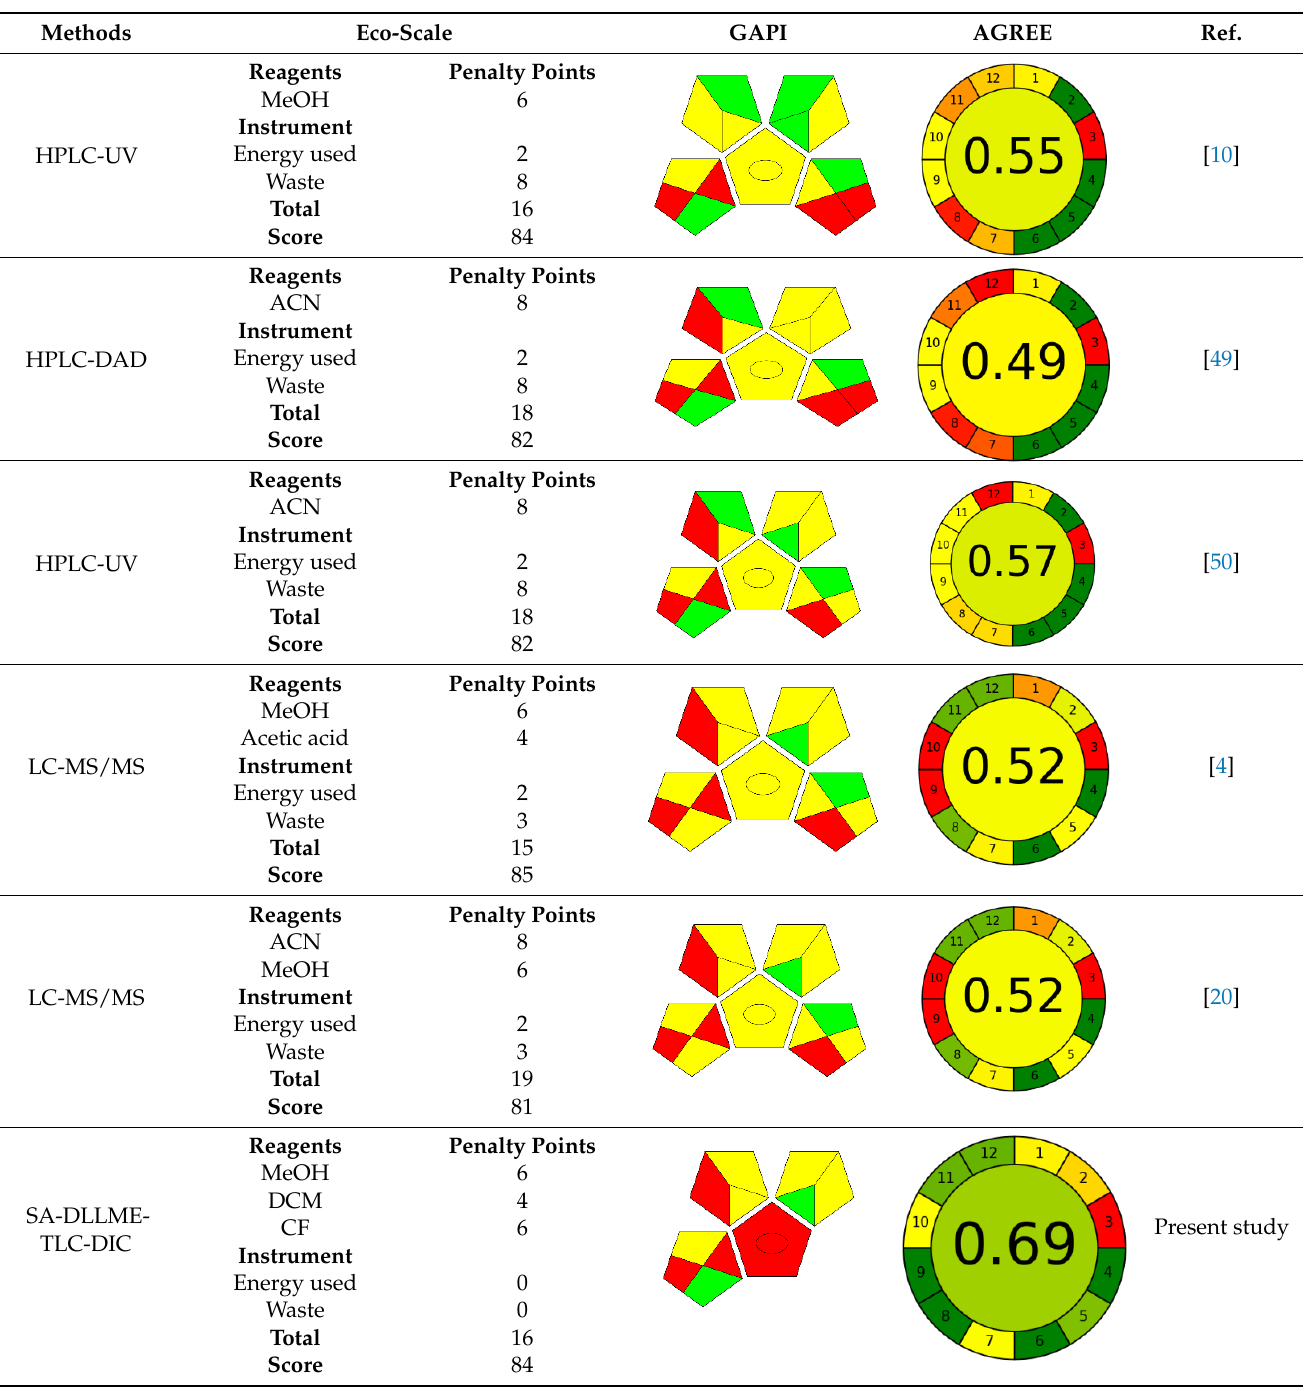
Table 5. Comparison of the proposed method with previously published methods for determining FAV in biological samples.